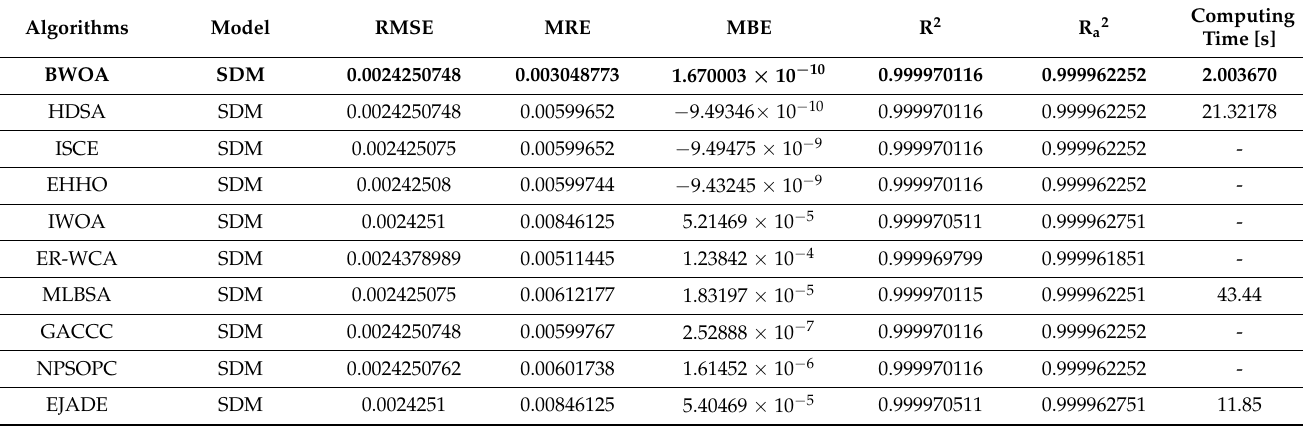
Table 7. Statistical tests of the PWP201 photovoltaic panel for different